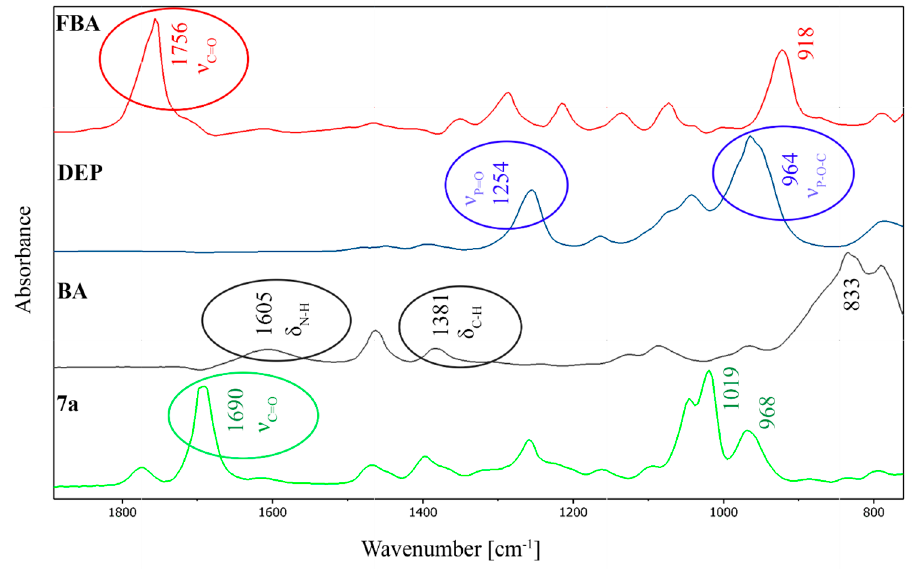
Figure 2. IR spectra of the reaction components in ethanol (absorptions of the solvent were subtracted for clarity).